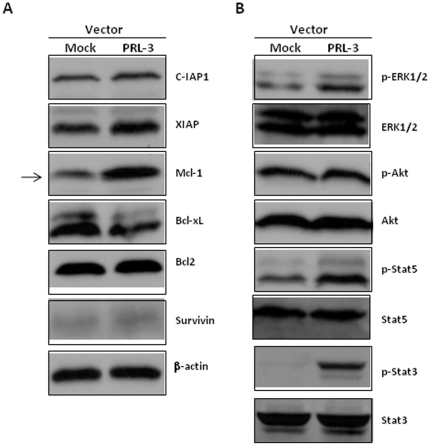
Comparisons of a panel of anti-apoptotic proteins and signaling transduction pathways in MOLM-14-Mock and MOLM-14-PRL3 cells.The two isogenic cells were lysed and subjected to 10% to 12% SDS-PAGE. Western blots were detected with the indicated antibodies for the assessment of expression level changes in anti-apoptotic proteins (A) and PI3K/Akt, MAPK/ERK and Stat pathways (B). β-actin was used as a loading control. Arrow highlighted Mcl-1.